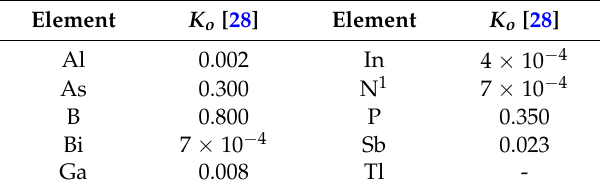
Table 1. Distribution coefficient ( K o ) of studied elements in this work at melting point of Si. Element K o [28] Element K o [28] Element K o [28] Element Al 0.002 In 4 × 10 − 4 0.300